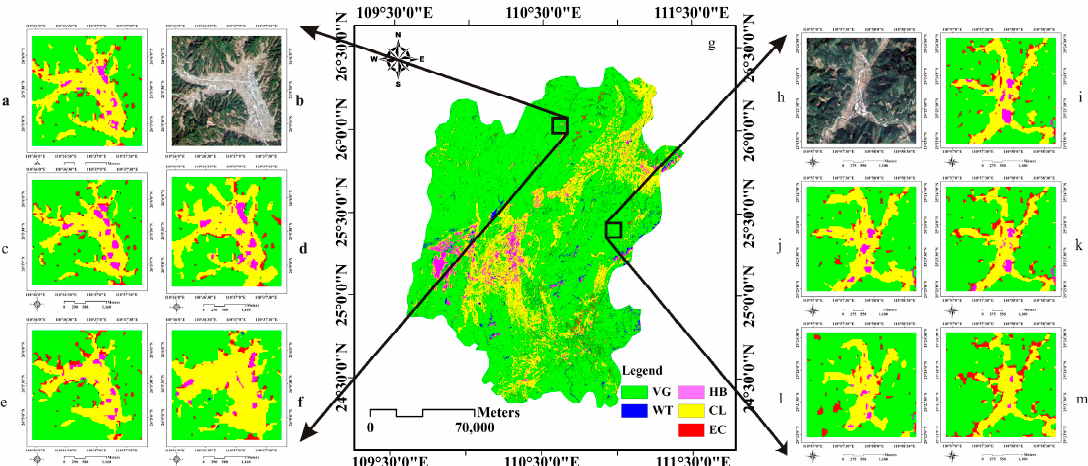
Figure 17. ( a – m ) Magnified windows of classification results in the first test area: ( g ) the classification results of SAE; ( b , h ) ground truth; and magnified windows of the classification results of: ( a , i ) MVU-based CL-DT; ( d , j ) CL-DT; ( c , k ) SAE; ( f , l ) CART; and ( e , m ) RFs.